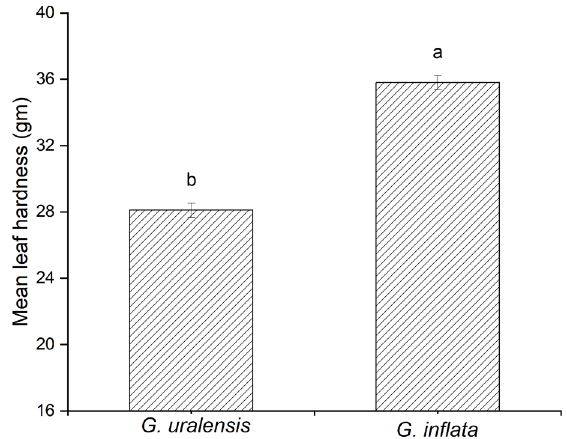
Figure 3. Leaf hardness of two licorice ( Glycyrrhiza ) species. Means with differing letters are significantly different (P <